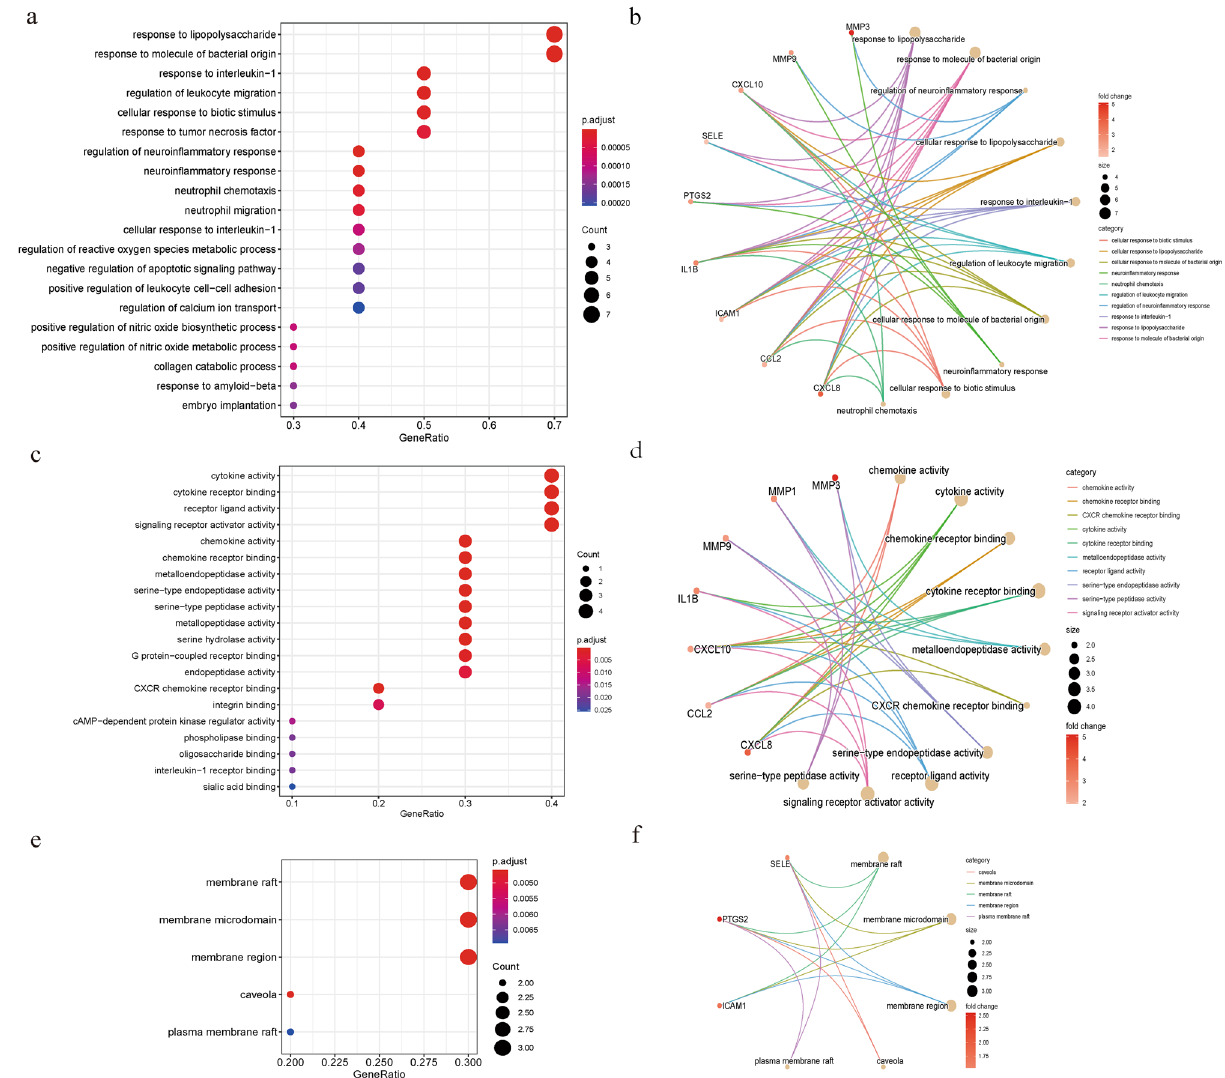
Figure 4. Bubble map of GO-BP, GO-MF, GO-CC and KEGG enrichment analysis and related gene circle map. ( a ) The top 20 noteworthy GO-BP terms enriched by Hub genes in the pharmacological network. The ratio of genes enriched in each term is recorded on the horizontal axis. The gene ratio is the ratio of the number of genes enriched in each term to 10 Hub genes. The larger the bubble, the more genes are involved in the pathway. The color of each bubble represents the adjusted p-value of each GO term. The redder the color of the term, the smaller the adjusted p-value. ( b ) A circle diagram showing the top 10 BP terms and related genes. The line color represents the relevant term. Bubble size represents the number of genes enriched in the term, and the more genes involved, the larger the bubble. Gene color means that the higher the Fold Change, the darker the color. ( c ) The top 20 noteworthy GO-MF terms enriched by Hub genes in the pharmacological network. ( d ) Circle diagram of the top 10 MF terms and related genes. ( e ) The GO-CC terms are enriched by Hub genes in the pharmacological network. ( f ) Circle diagram of 5 CC terms and related